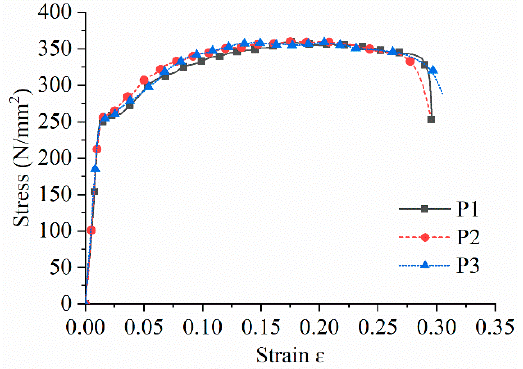
Figure 4. Typical stress–strain curves of the tensile coupons with a thickness of 1.2 mm.